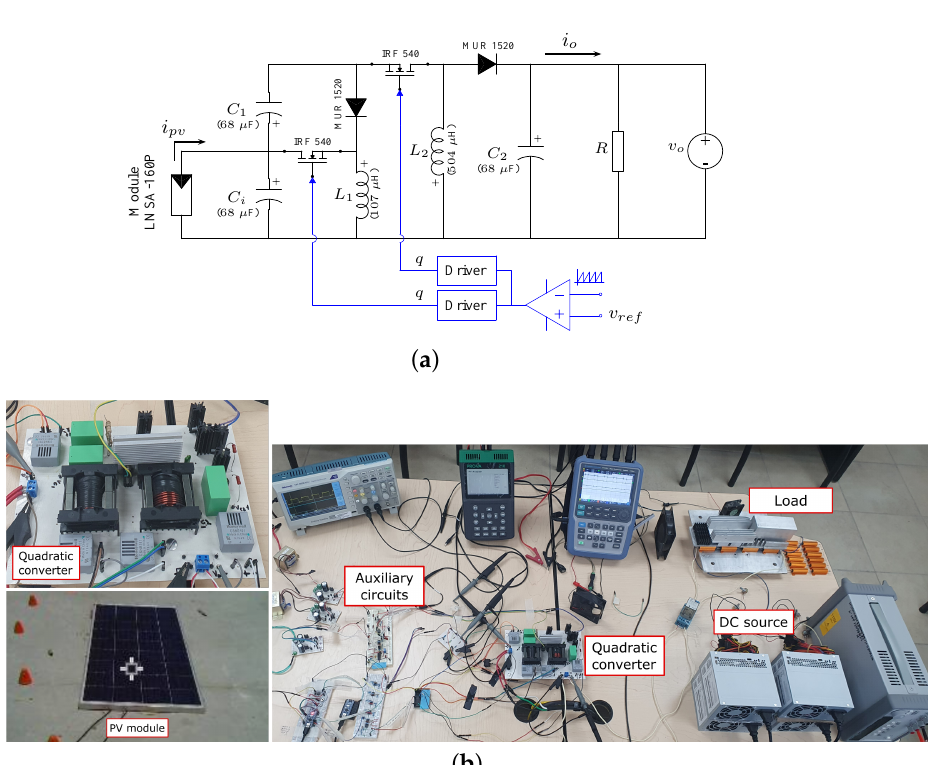
Figure 12. Experimental prototype of step-up/down quadratic converter. ( a ) Circuit diagram. ( b ) Experimental setup.